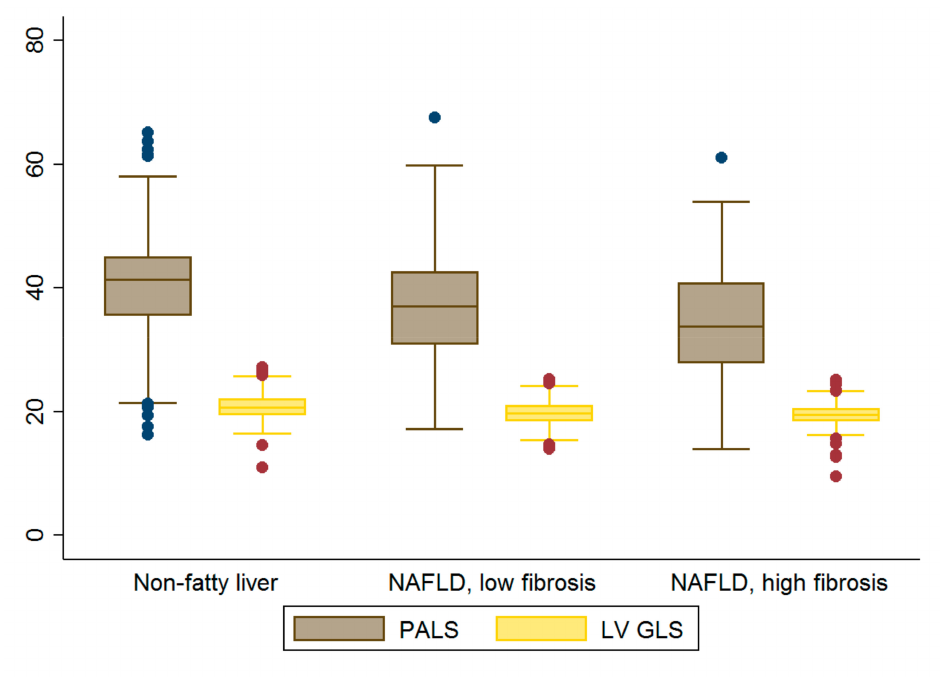
Figure 3. Box plots of LA and LV strain. Graded decreases in LA strain were observed across all three groups (all p < 0.05). Abbreviations: GLS= global longitudinal strain, PALS = peak atrial longitudinal strain.